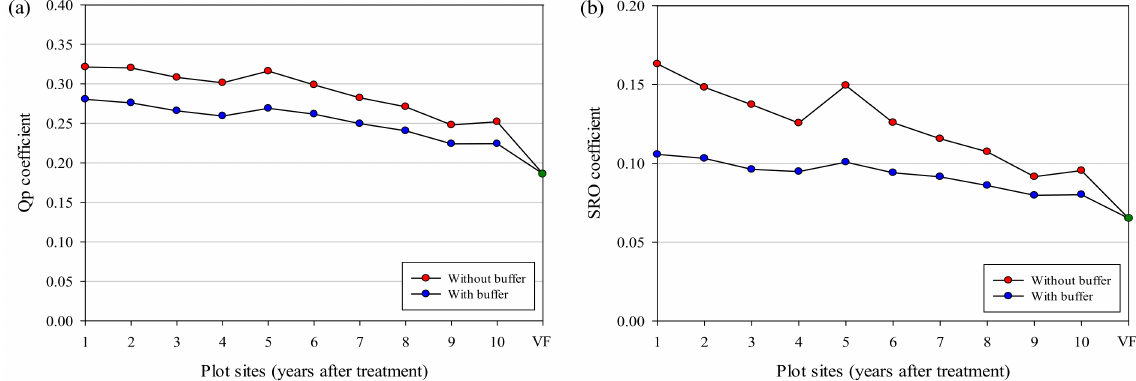
Figure 14. ( a ) Coefficient of Qp to peak rainfall intensity. ( b ) Coefficient of total SRO to the amount of